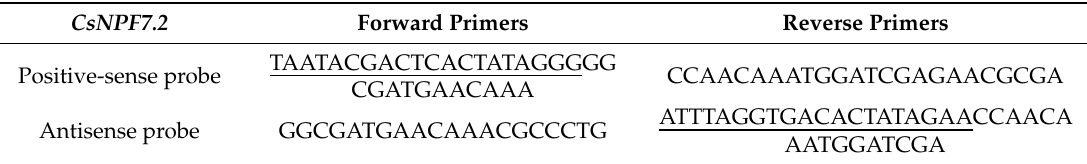
Table 1. CsNPF7.2 (Nitrate Transporter Families protein) gene in situ hybridization probe primer table.